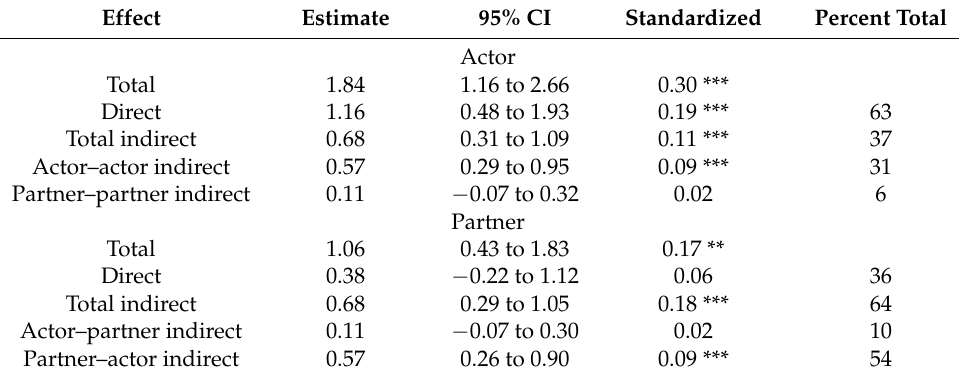
Table 4. Effects of self-perceived supportive DC mediation.